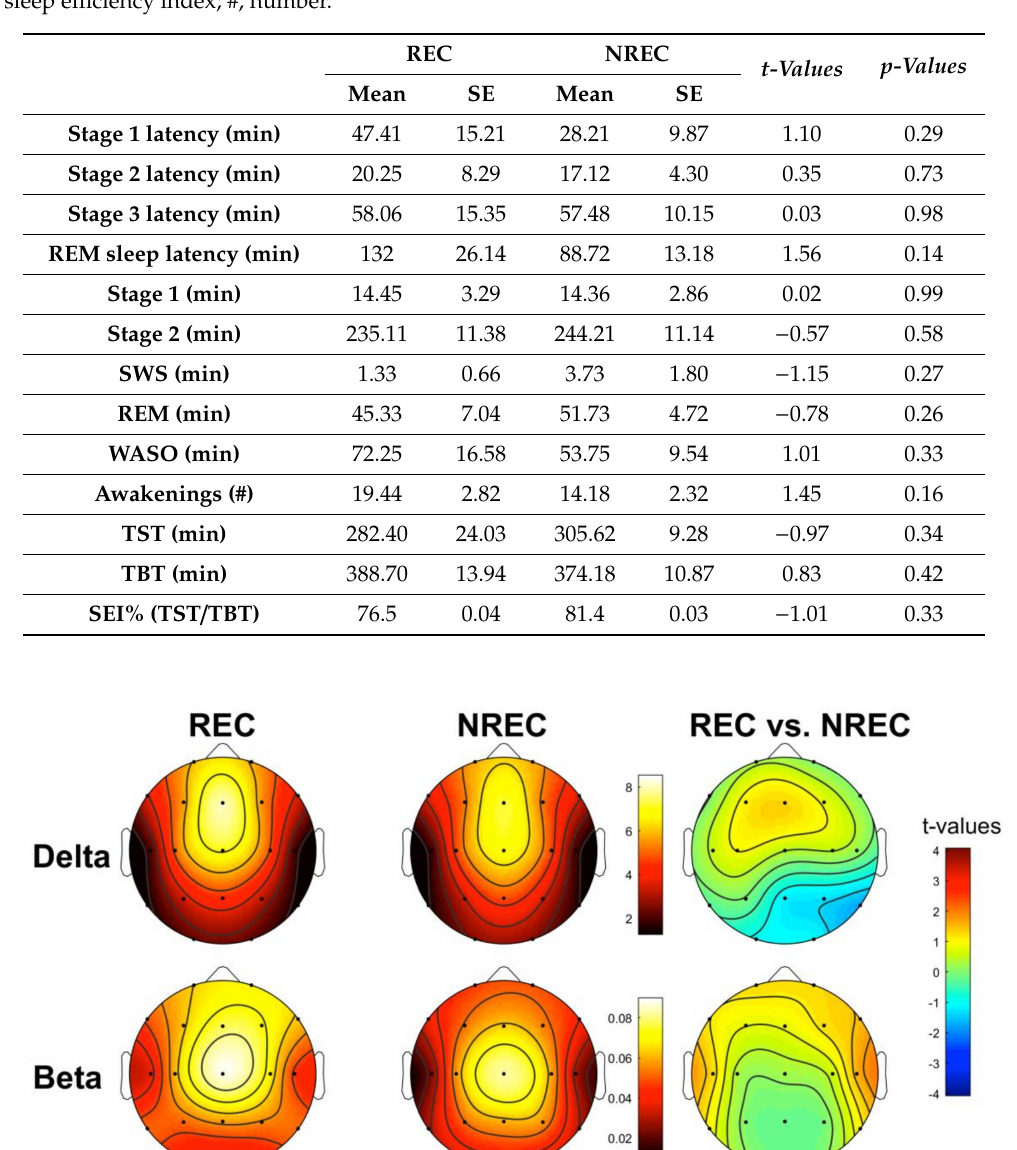
Table 1. Means and standard errors (SEs) of the polysomnographic (PSG) variables of the recallers (REC) and non-recallers (NREC) groups. The results of the unpaired t -test are also reported. REM, rapid eye movement; WASO, wake after sleep onset; TST, total sleep time; TBT, total bed time; SEI, sleep e ffi ciency index; #, number.